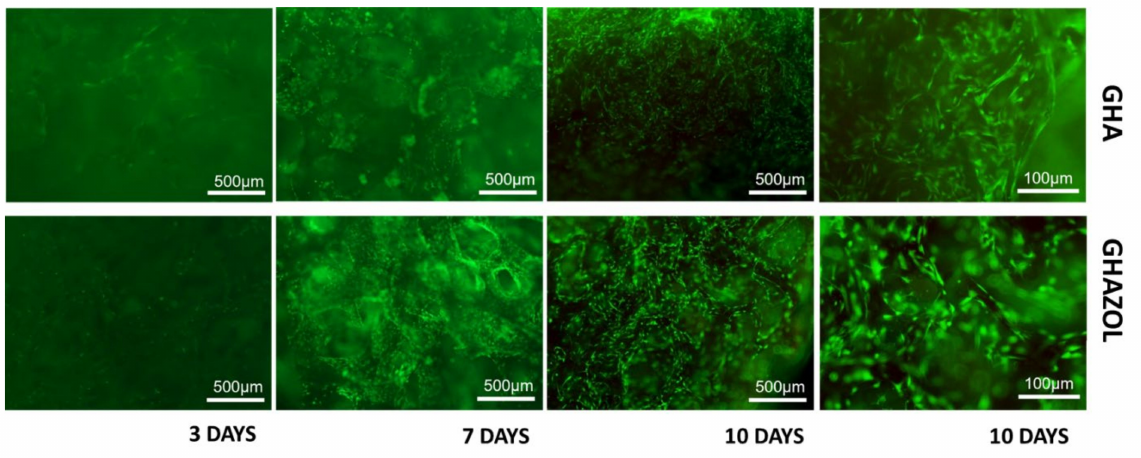
Figure 4. Viability of materials. Live and dead cell staining was conducted on differentiated hMSC in the 3D fracture models treated with GHA and GHAZOL after 3, 7 and 10 days of culture. Viable cells stain green while dead cells stain red: images show that cells grew regularly into both 3D porous scaffolds as evident by the green fluorescent dye in absence of the red fluorescence dye (4 × magnification: bar = 500 µ m; 10 × magnification: bar = 100 µ m).